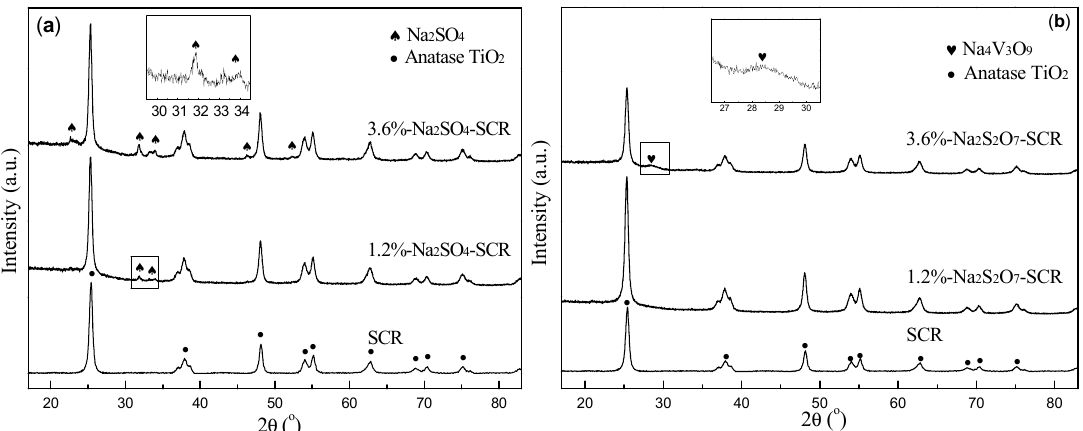
Figure 11. XRD results of the ( a ) Na 2 SO 4 and ( b ) Na 2 S 2 O 7 poisoned catalysts.